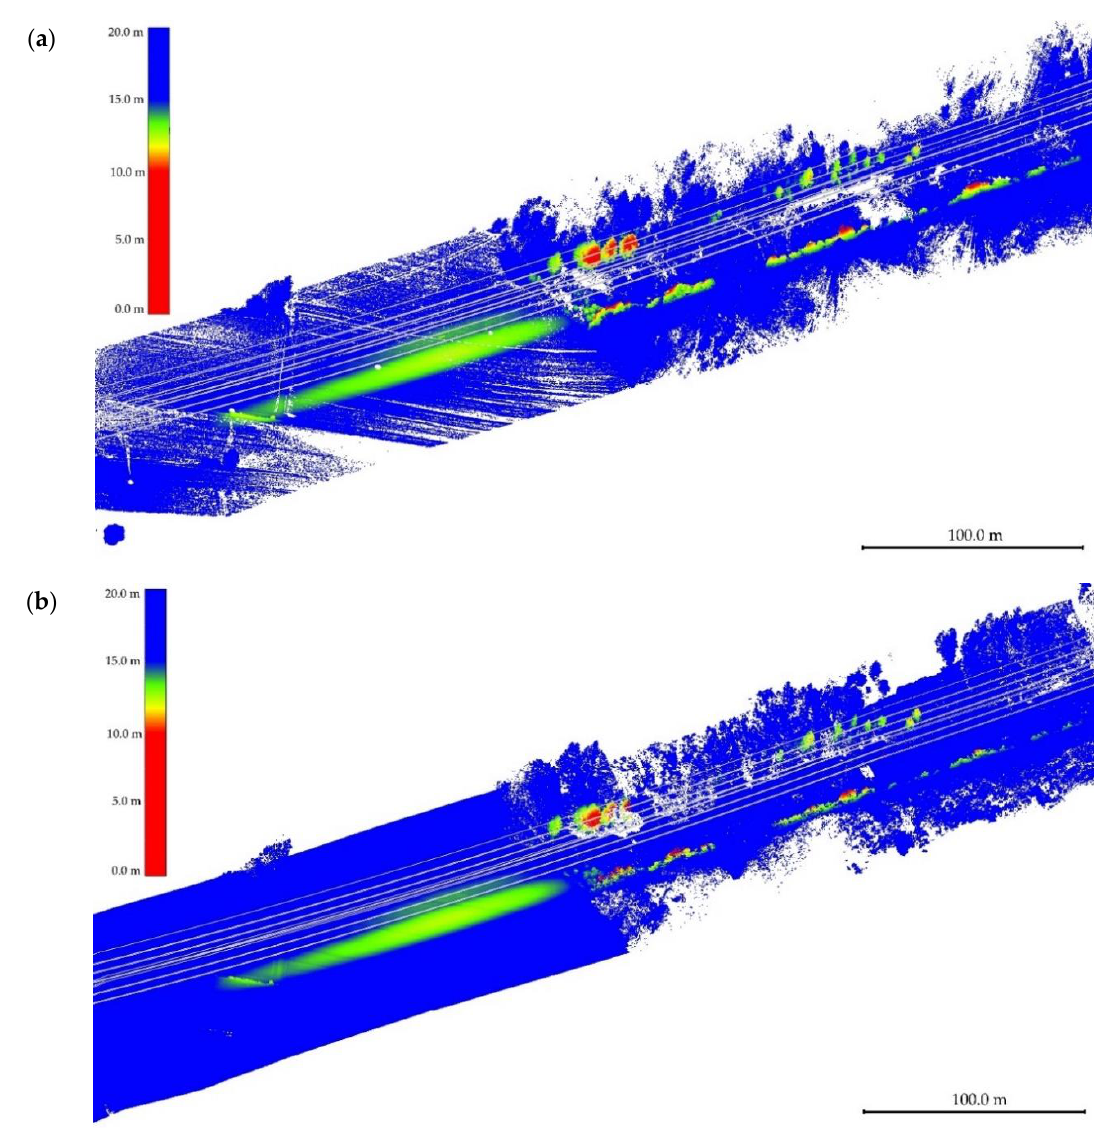
Figure 18. Results of the monitoring of occlusions of a high-voltage power line corridor (Dataset IV): ( a ) based on TLS data; and ( b ) based on UAV data. The red color indicates points less than 10 m from the wires and the blue color indicates those more than 15 m away.